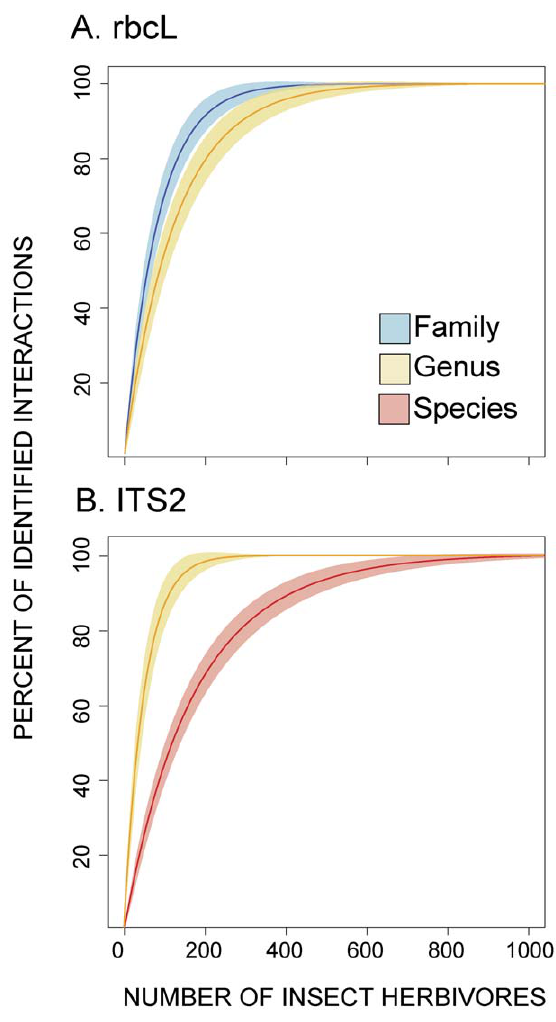
Figure 5. Sampling effort and successful identification of insect herbivore host plants using two molecular markers (Mean ± SD). Diet identifications were performed by comparing DNA sequences from insect gut contents with DNA barcode libraries containing sequences of all potential host plants present in the study area (identification probabilities used to estimate sampling efforts are included in Table 1). A . rbcL DNA fragments allowed the identification of host plants to the family and genus taxonomic levels. B . ITS2 sequences identified insect hosts to the genus and species taxonomic